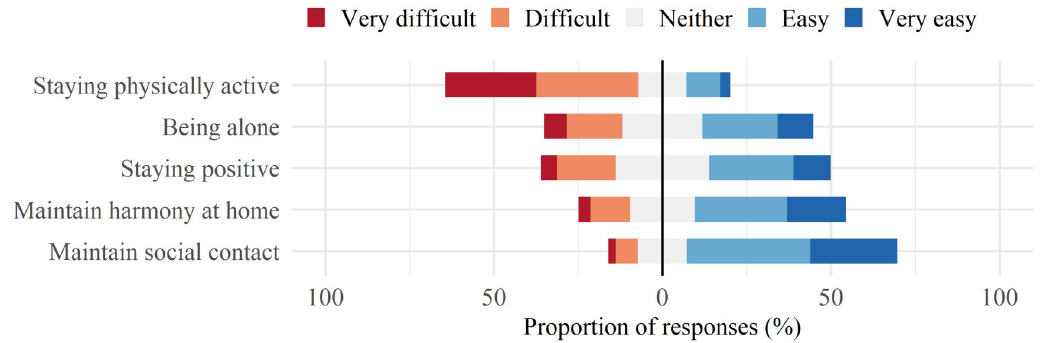
Fig 3. Specific difficulties of isolation—Problematic aspects when undergoing the time in confinement. Visualizes the percentage of the population affected by 5 difficult aspects of isolation prespecified in the questionnaire, on Likert scale from very difficult to very